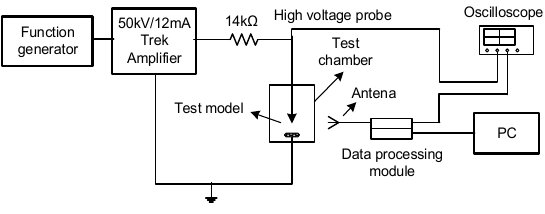
Figure 5. The experiment setup.